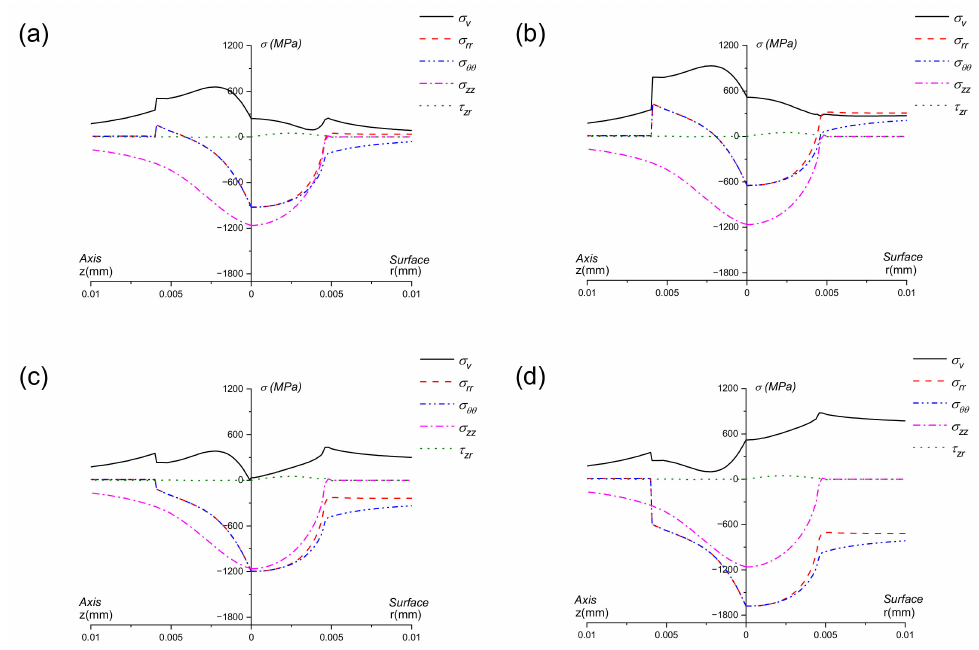
Figure 10. Contact stresses at the axis of symmetry and the surface with different surface layer. The parameters are E s = 200 GPa, E l = 400 GPa, Y s = 600 MPa, Y l = 952 MPa, t / R = 0.006, and P = 0.05 N. ( a ) Without residual stress. ( b ) With tensile residual stress. ( c ) With compressive residual stress. ( d ) With excessive compressive residual